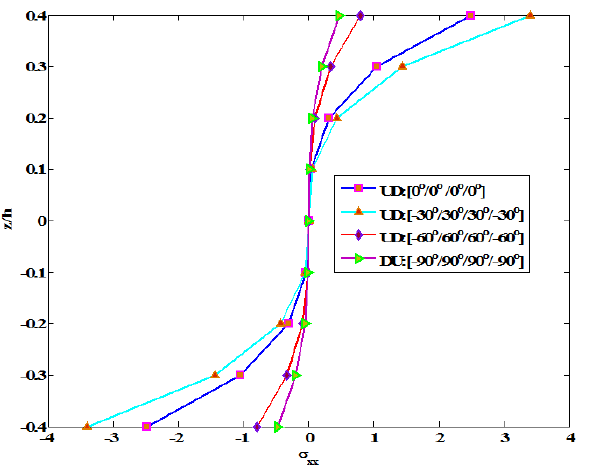
Figure 10: The non-dimensional stress σ xx for angle–ply [- θ / θ / θ /- θ ] FG-V SWCNT-FG plate with different lamination scheme